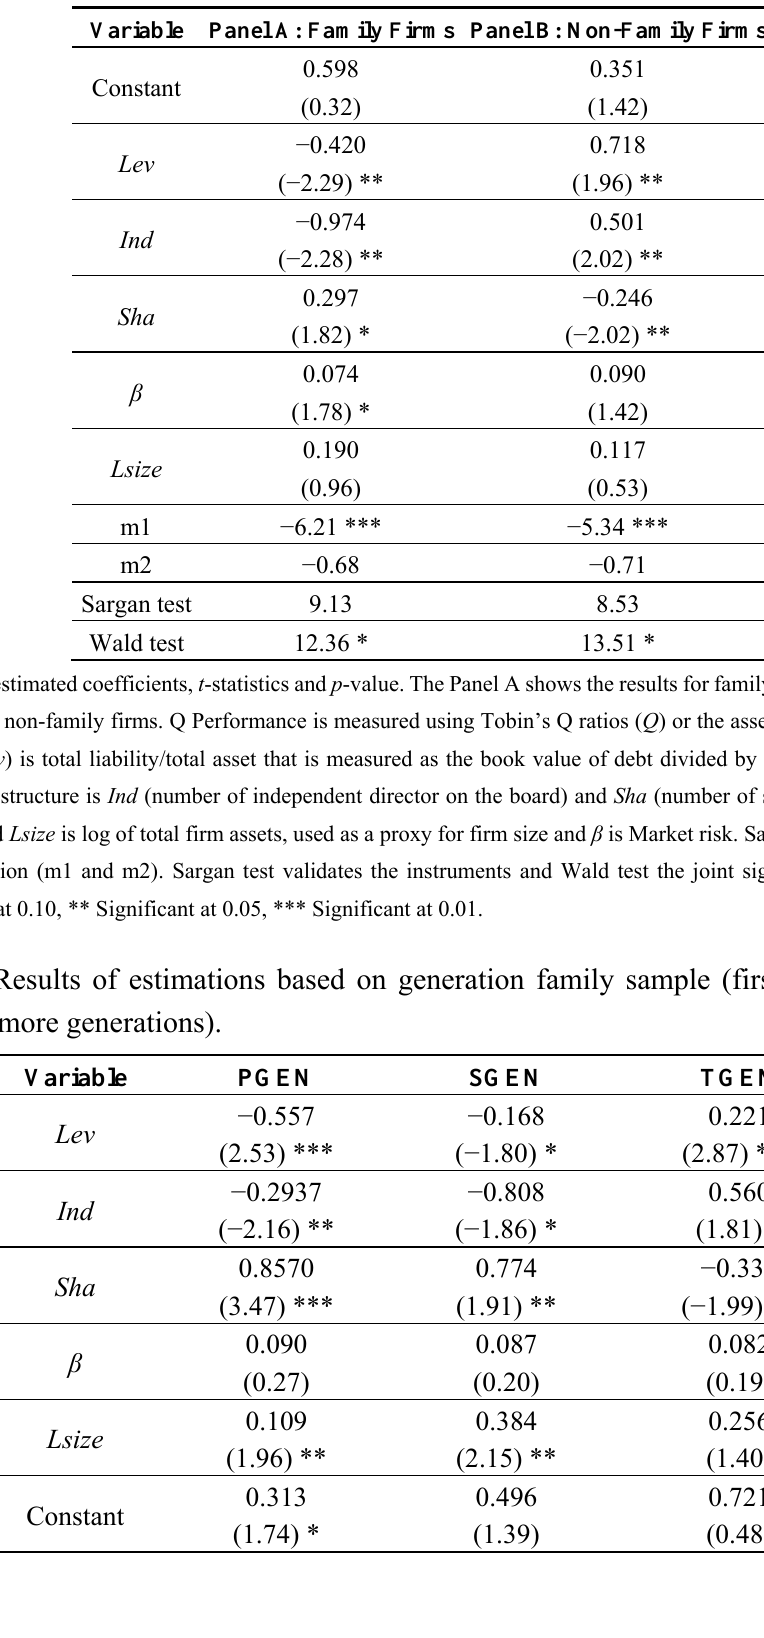
Table 6. Results of GMM Model based on family and non-family sample (family holds more than 51 percent ownership).